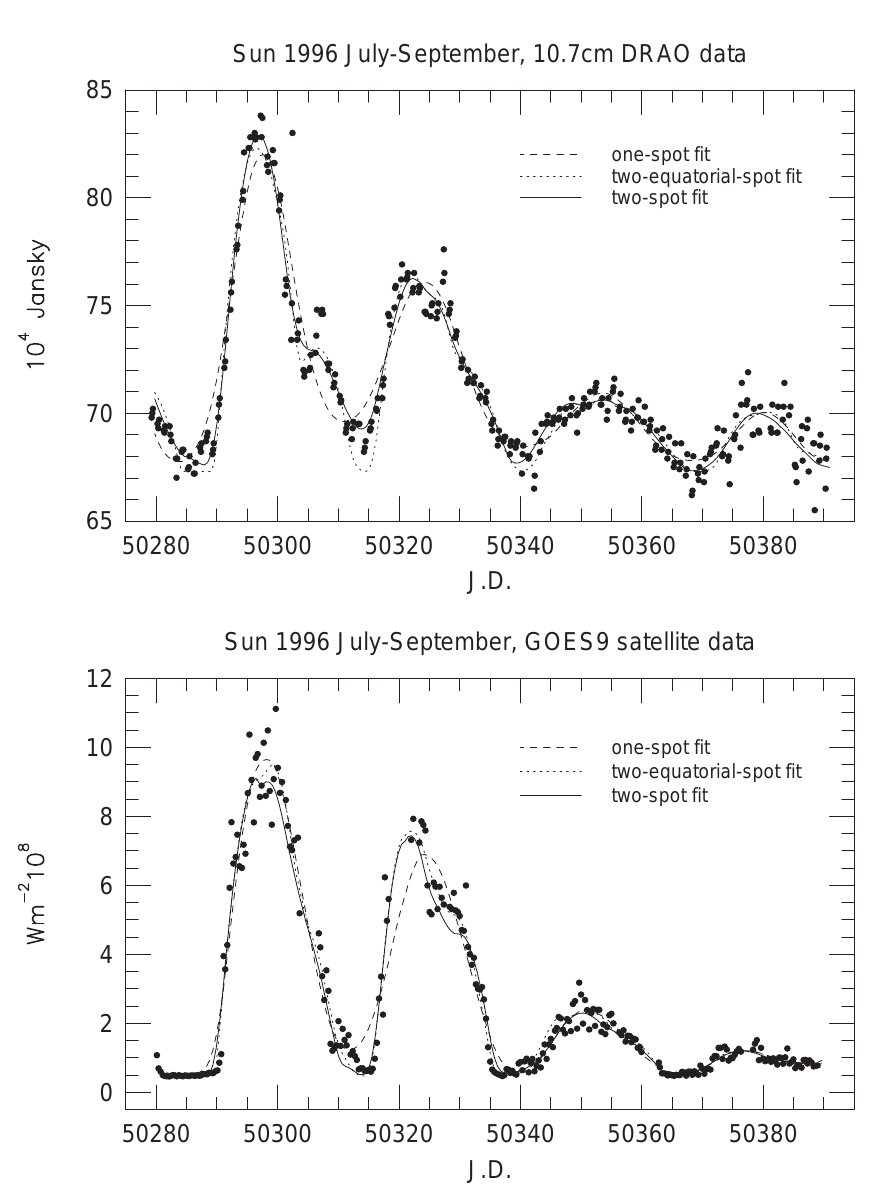
Figure 22: DRAO 10.7-cm radio flux (upper panel) and GOES SXR flux (lower panel) modulation during the long-term evolution of AR 7978 during four rotations used for testing photometric starspot models. The inset legend indicates the line-style used for one-spot, two equatorial spot, and two-spot fits of the light-curves. Image reproduced with permission from Ol´ah et al. (1999), copyright by